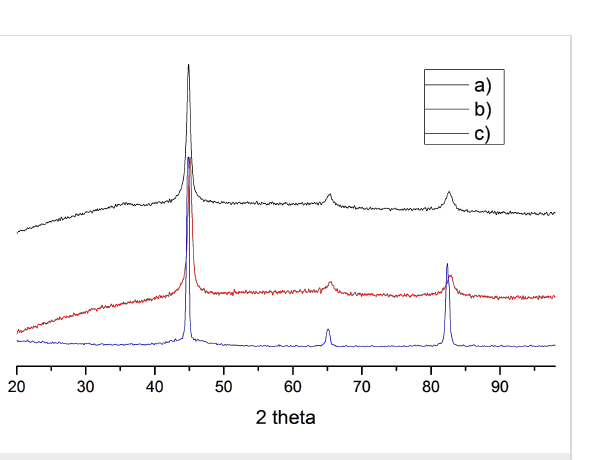
Figure 3: XRD pattern of (a) freshly prepared 4-nitrophenyl-coated ZVI NPs, (b) corresponding particles after 6 months, and (c) bcc α -Fe (JCPDS File #